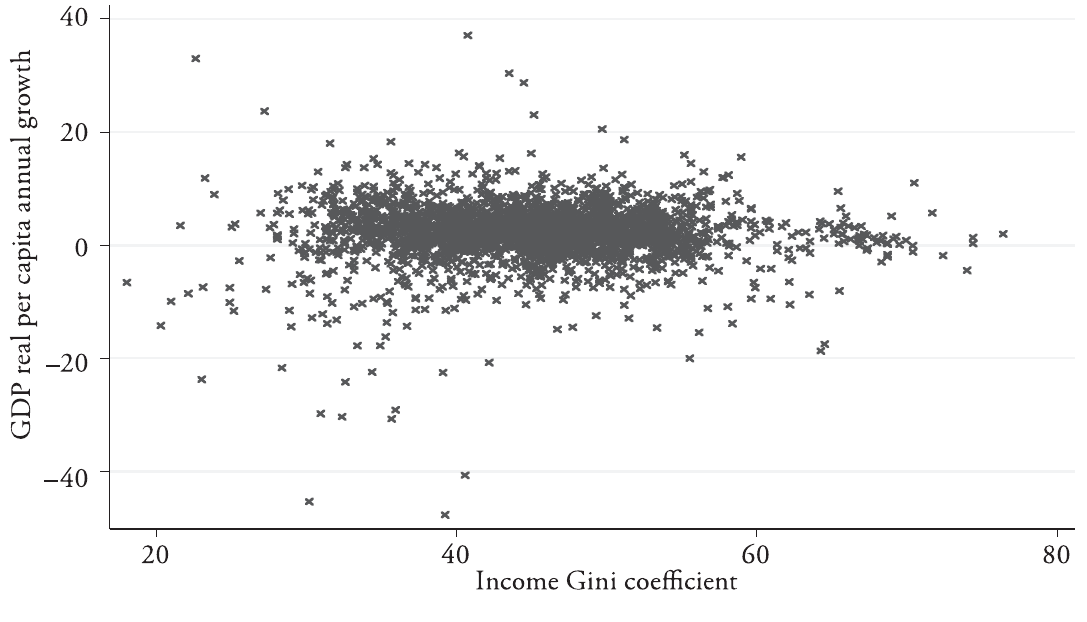
Figure 2.2: Scatterplot oflncome Gini vs GDP Real Per Capita Annual Growth, 154 Countries,